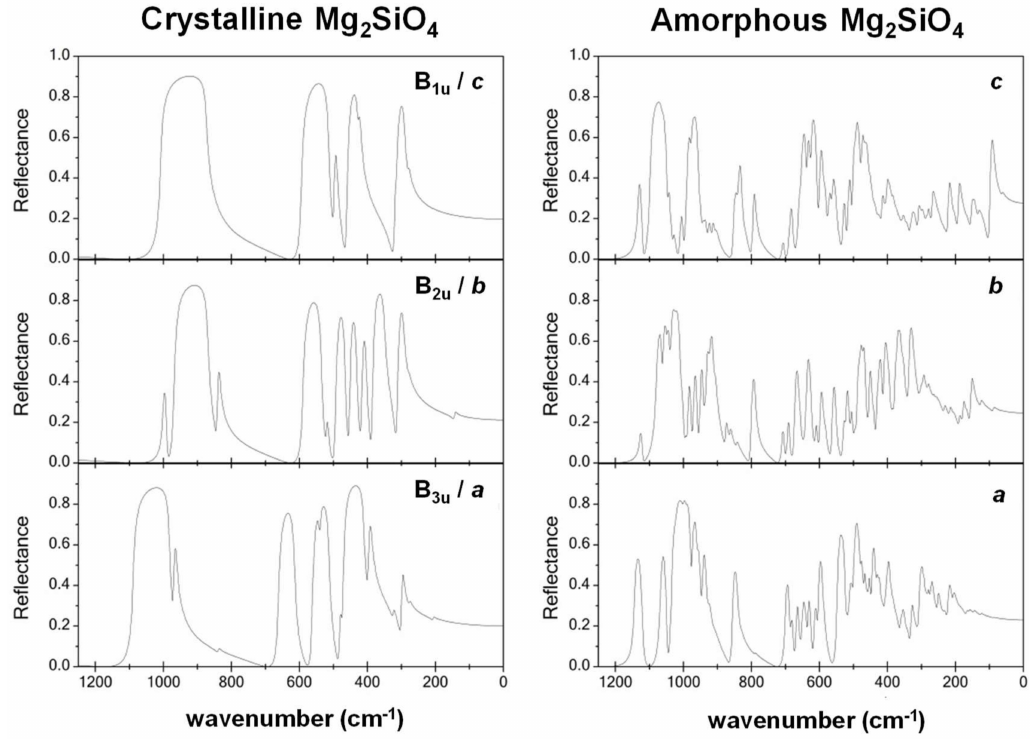
Figure 7. B3LYP-simulated reflectance spectra of the crystalline and amorphous forsterite along the a , b , and c